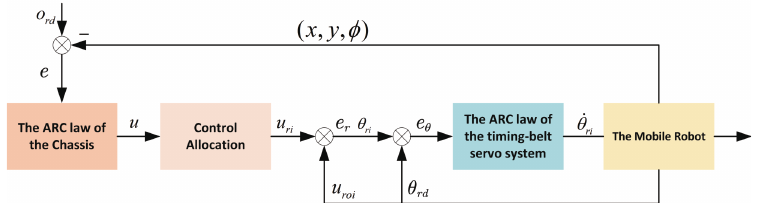
Figure 3. The overall control